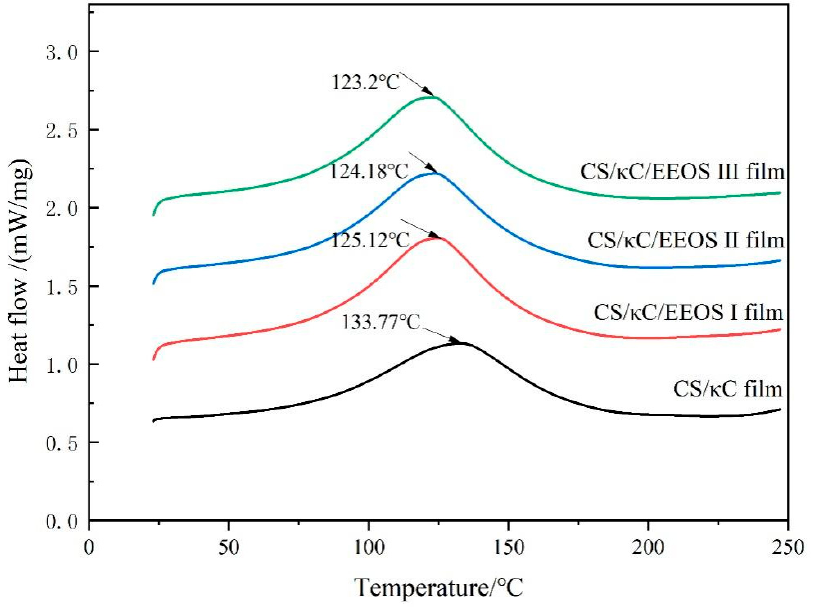
Figure 6. Thermodynamic properties of the CS/ κ C, CS/ к C/EEOS I, CS/ к C/EEOS II, and CS/ к C/EEOS III composite films.